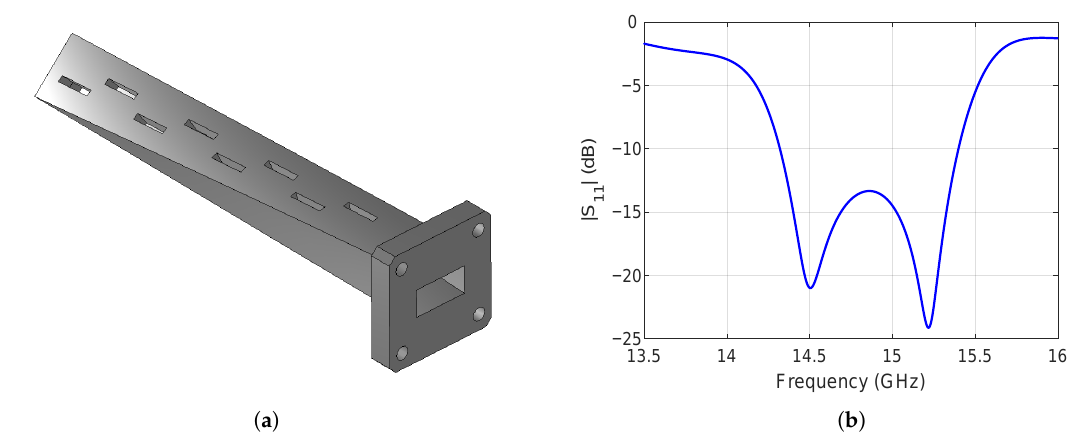
Figure 7. ( a ) Slotted-twisted waveguide antenna and ( b ) computed | S 11 | . The antenna retains the design values reported in Table 1 except for d short , now equal to 7.954